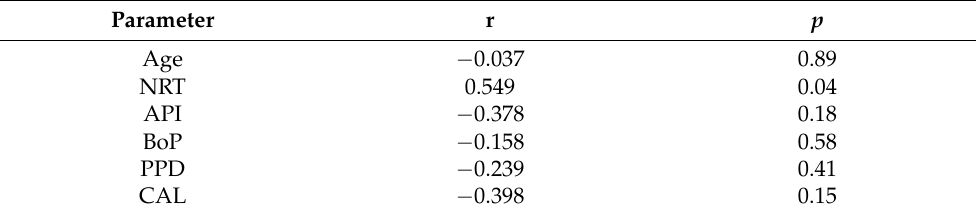
Table 10. Correlations between IL-18 gingival expression and the selected clinical parameters in the control group.